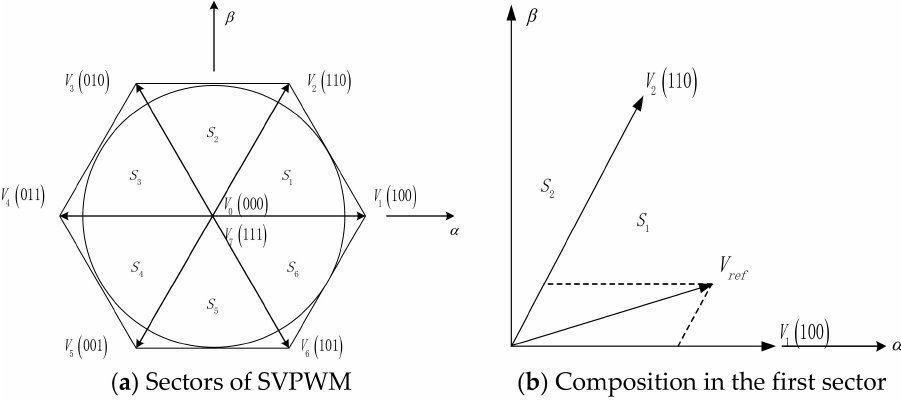
Figure 2. Conventional SVPWM.